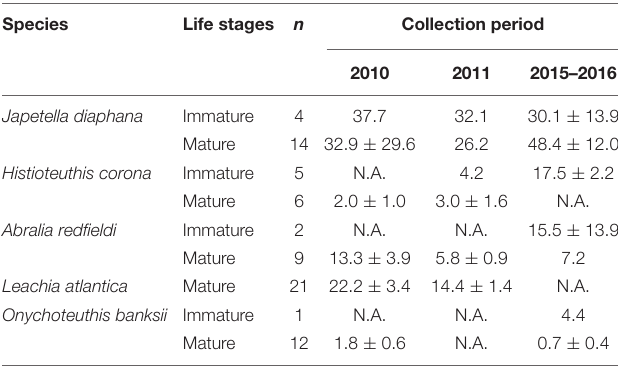
TABLE 1 | Temporal variability of PAH concentrations ( µ g/g lipid weight) in mantle tissue of mature and immature deep-sea cephalopods from the northern